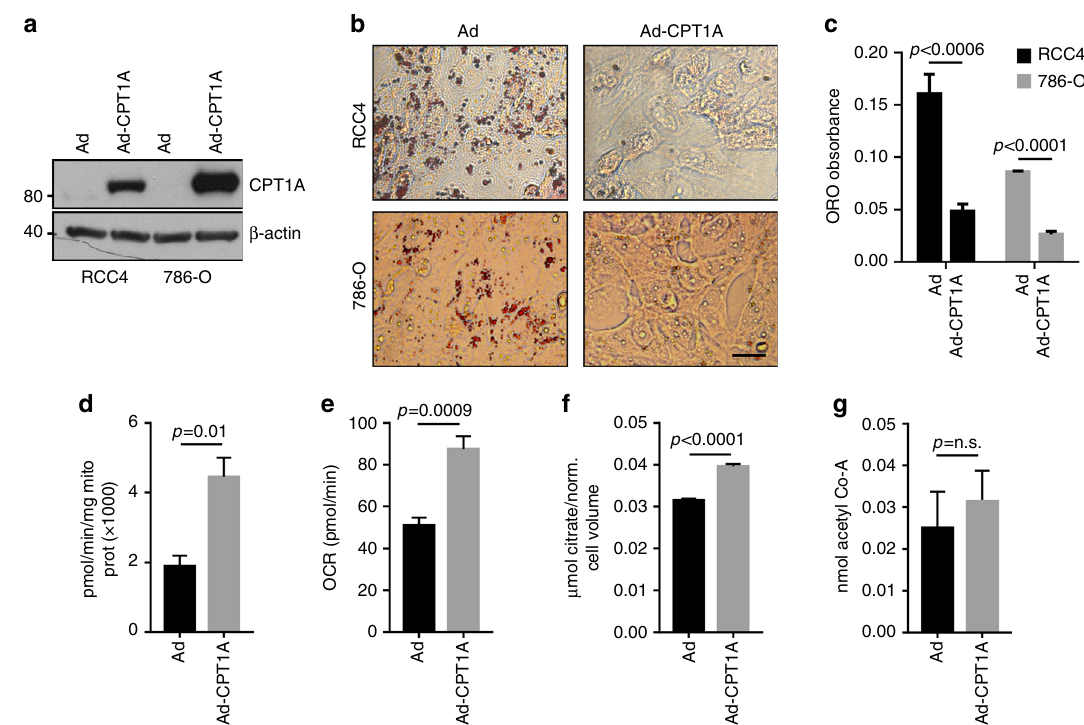
Fig. 6 CPT1A expression prevents lipid deposition and alters mitochondrial function in ccRCC cells. a Western blots of RCC4 and 786-O cell lysates after adenoviral infection with CPT1A of GFP-expressing adenovirus stained for CPT1A or β -actin. b Photomicrographs of Oil Red O staining of RCC4 or 786-O cells after infection with GFP or CPT1A adenovirus. Bar = 10 μ m. c Quanti fi cation of Oil Red O staining depicted in b . d CPT1A activity measurement in adenovirally infected RCC4 cells. e Oxygen consumption rate (OCR) of adenovirally infected RCC4 cells. f Citrate levels in adenovirally infected RCC4 cells. g Acetyl-CoA levels adenovirally infected RCC4 cells. Error bars represent standard deviations. p values of two-tailed Student ’ s t tests are